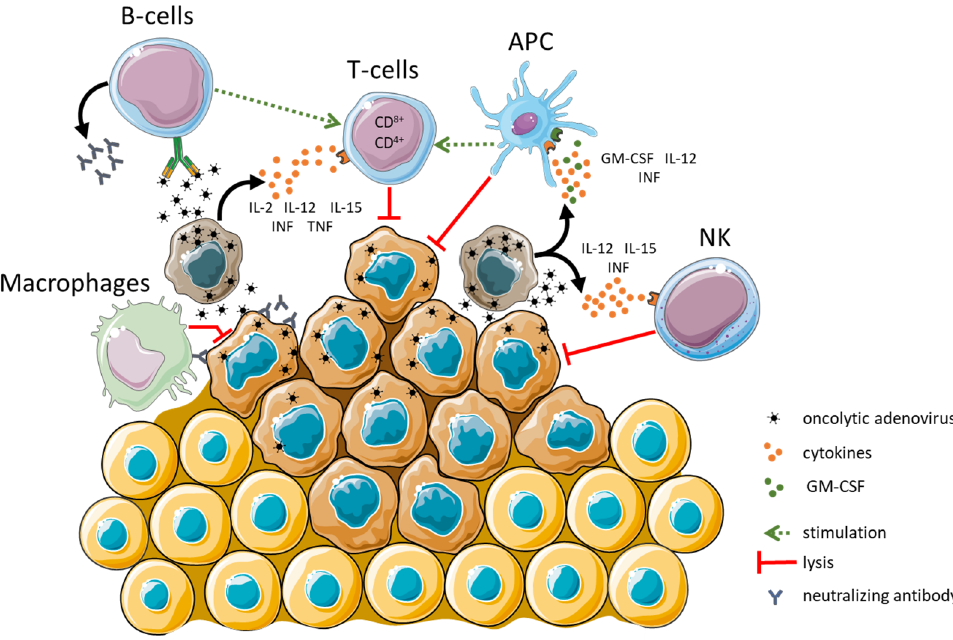
Figure 2. Activation of immune system by oncolytic adenovirus. Drawn by using pictures from Ser- vier Medical Art, licensed under a Creative Commons A tt ribution 3.0 Unported License (h tt ps://cre- ativecommons.org/licenses/by/3.0/, accessed on 21 March 2023).